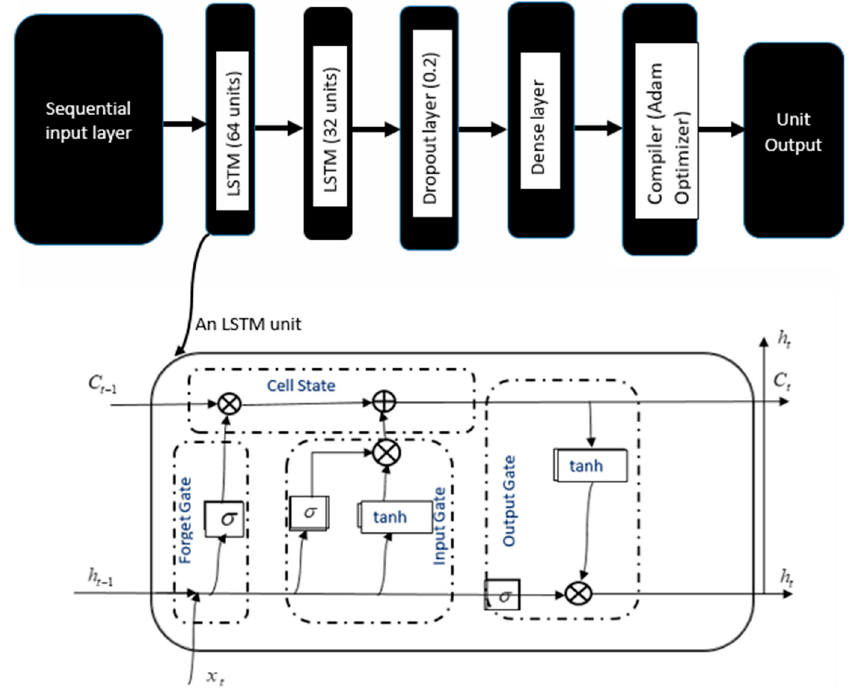
Figure 2. LSTM architecture with two LSTM layers (64 and 32 units each) stacked together followed by a drop-out layer to avoid overfitting, a dense layer, and a compiler. Below it is a representation of a unit LSTM architecture consisting of Forget gate to decide what must be removed from the ( h t − 1 ) state, the Input gate to write from present input to current cell state, and the Output gate to decide what to output from cell state using the sigmoid function. The outputs of the Input and Forget Gate are summed together to determine each current Cell State.